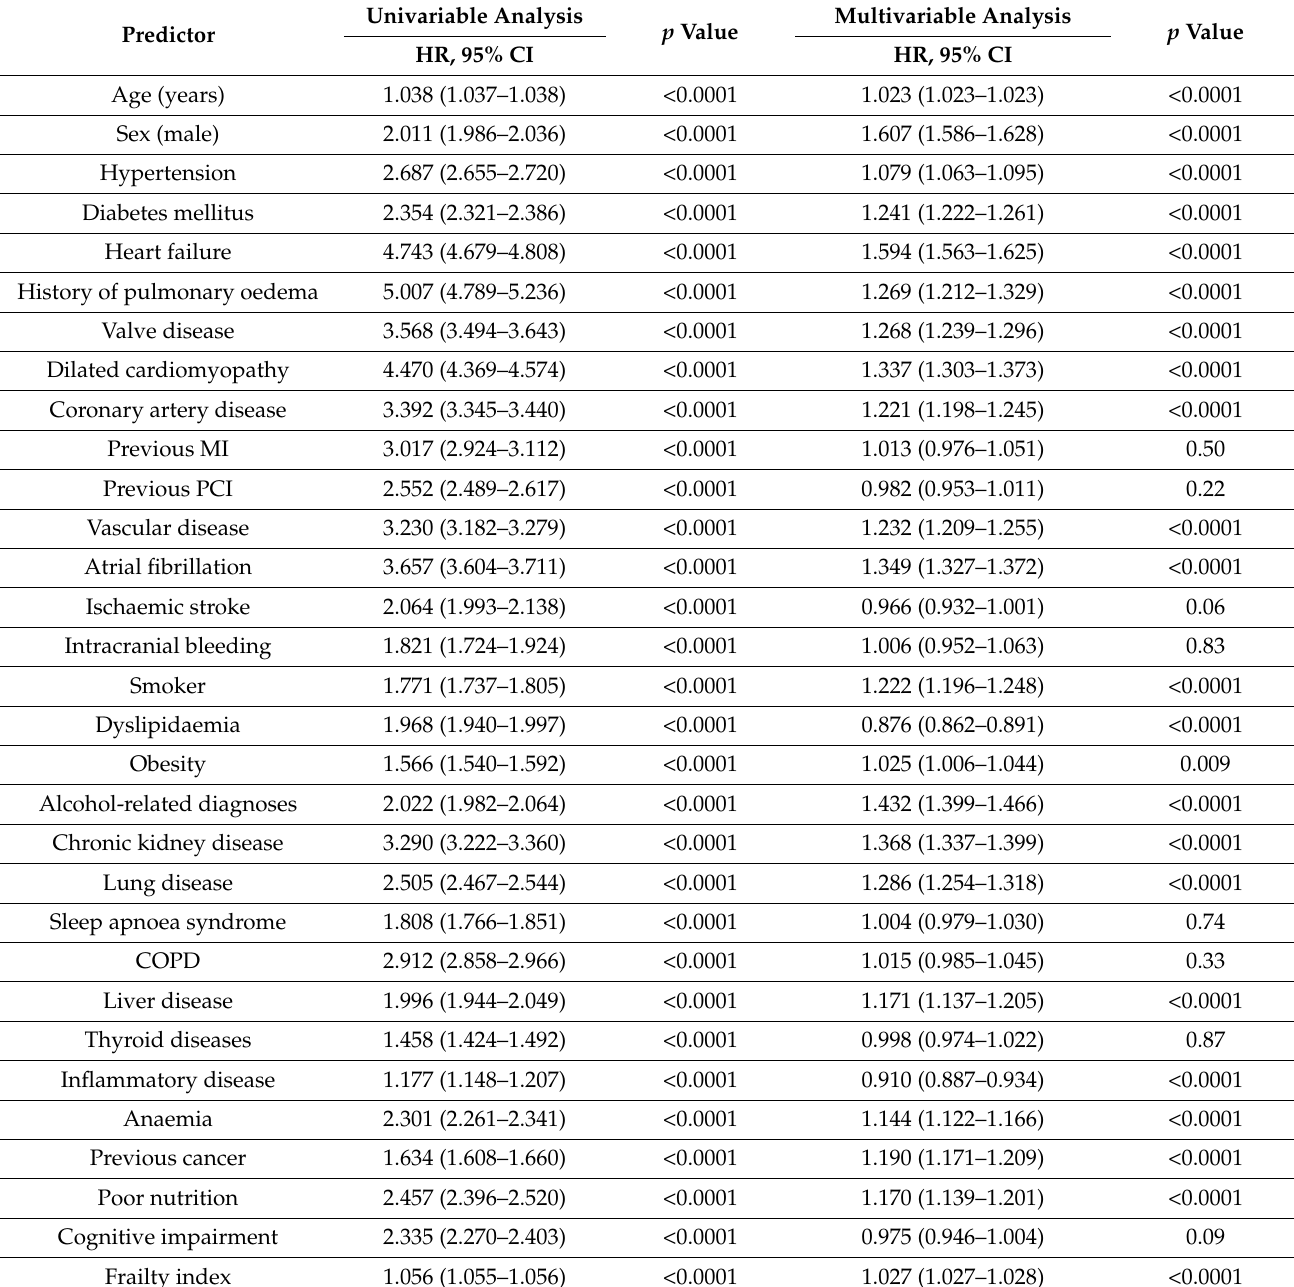
Table 3. Predictors of VT/VF/CA in hospitalised